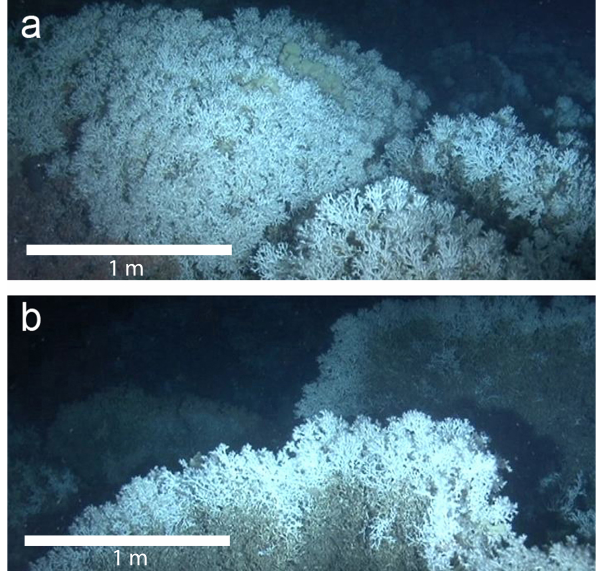
Fig. 2. Typical Primnoa resedaeformis and Paragorgia arborea colonies at the Røst Reef, Norway. (a) P. resedaeformis , the orange branching gorgonian in the lower centre of the image. Often located in cracks in the Lophelia pertusa structure or on the walls of coral blocks. (b) Three colonies of P. arborea . A large salmon-coloured colony in the middle distance, a pink colony on the top right and a salmon-coloured colony on the bottom right. The bottom-right colony has its polyps